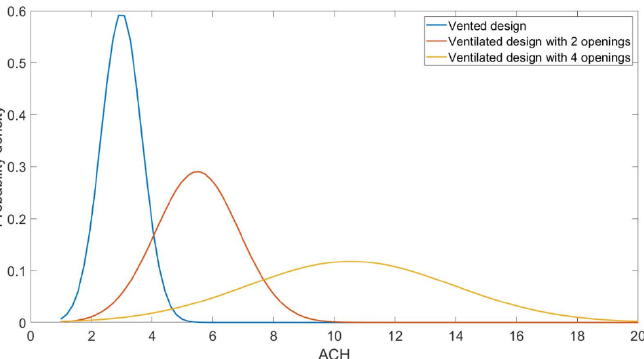
Figure 7. Probability density functions of the cladding ventilation rate (ACH) for a brick wall.